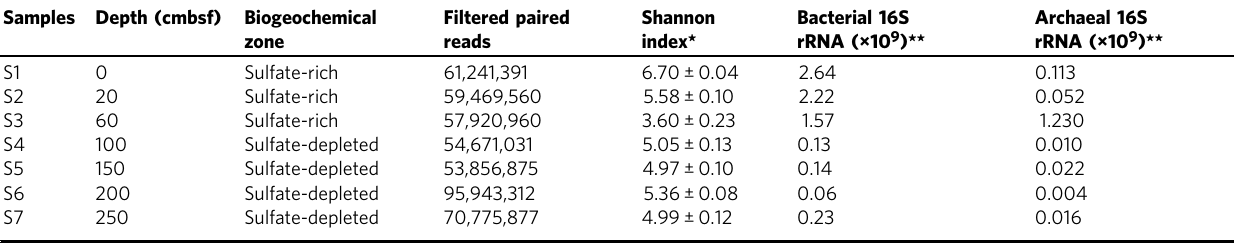
Table 2 Key features of sediment samples used for microbiological